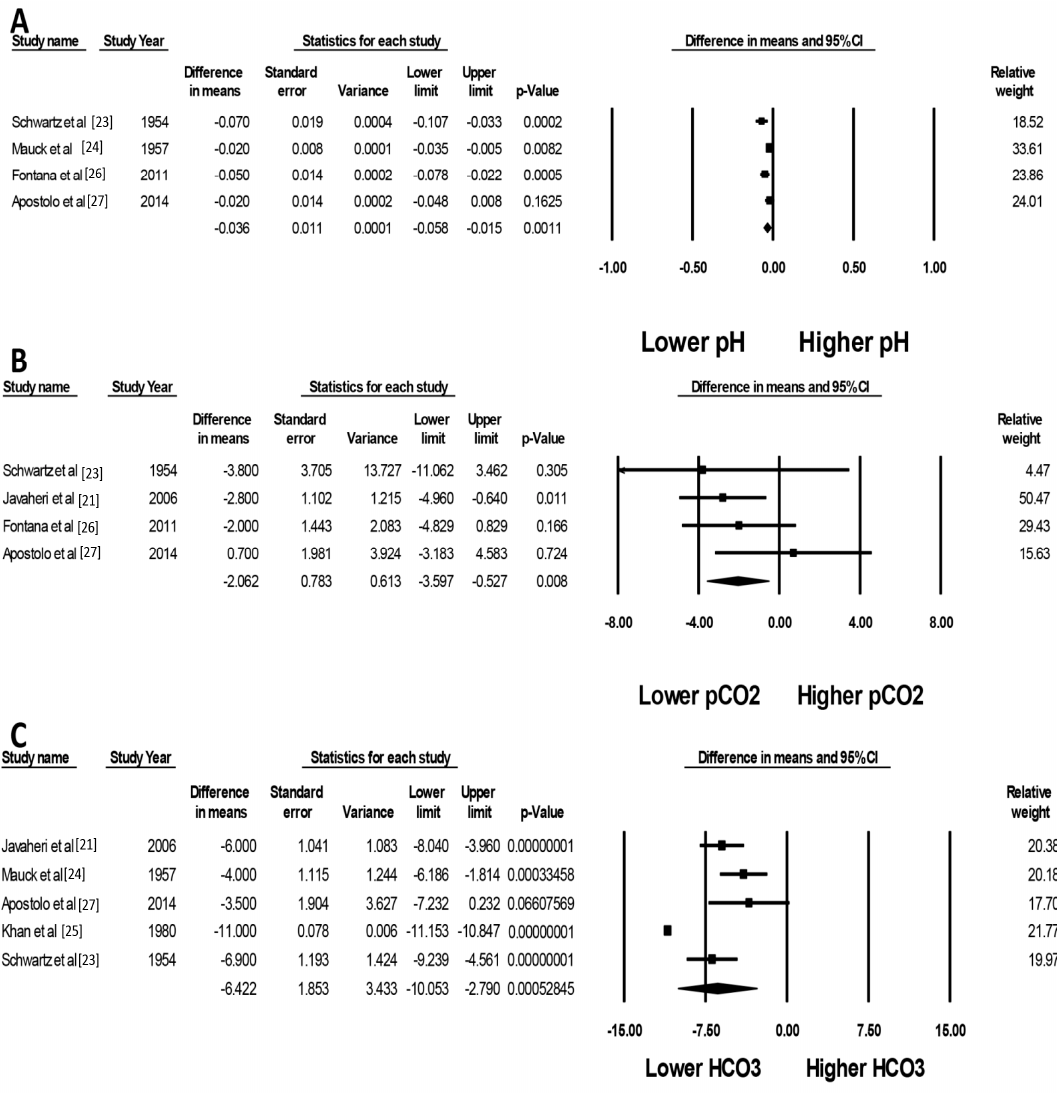
Figure 2. Forest plots of the included studies assessing the effects of acetazolamide on ( A ) pH; ( B ) pCO 2 ; and ( C ) bicarbonate. A diamond data marker represents the overall rate from each included study (square data marker) and 95% confidence interval (CI).